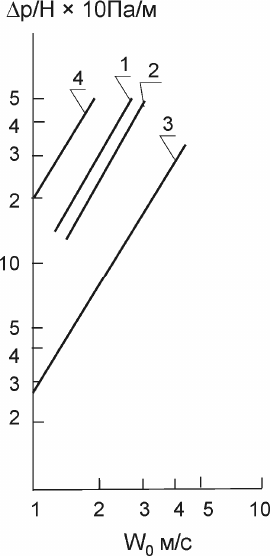
Fig. 2. Schedule of dependence of resistance of a layer of packing ∆Р/Н on air speed W 0 on full section of the empty device: 1 – Ceramic Intalox saddles, 50×50; 2 – Ceramic Pall rings, 50×50; 3 – Regular rings PSL type; 4 – Regular rings PSImax type